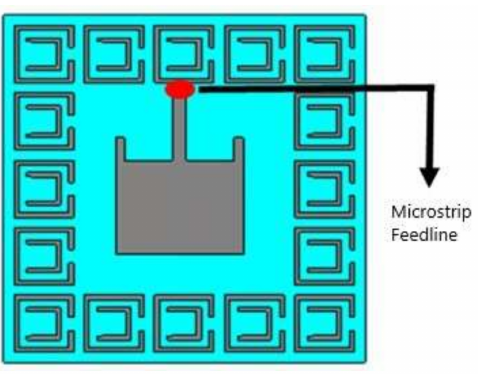
Figure 9. Geometric model (front view) of the dual-band SRR-based antenna.